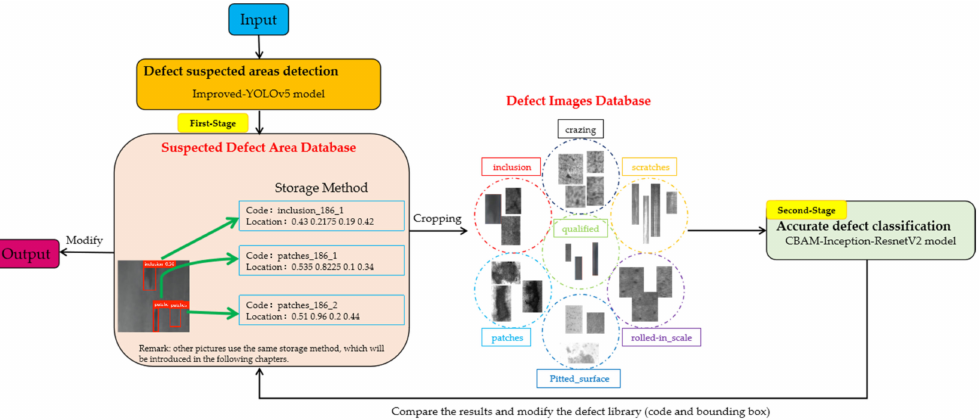
Figure 1. Two-stage defect detection framework in this